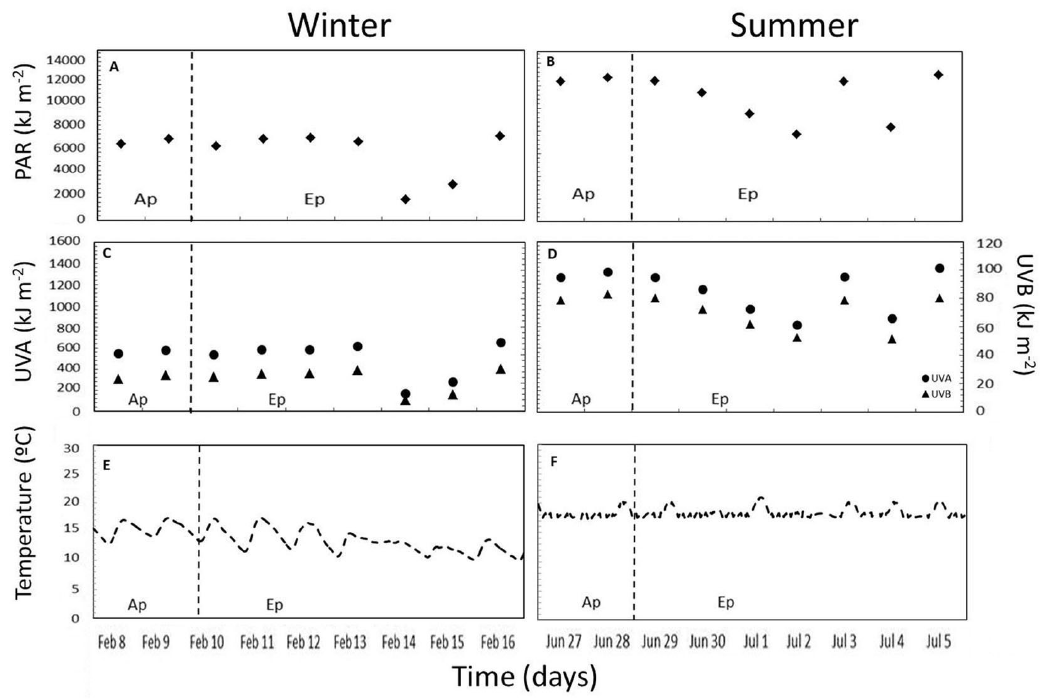
Fig. 1. – Daily integrated irradiance (DIE) in the air expressed as kJ m –2 of PAR (400-700 m) (A, B), UVA (320-400 nm) and UVB (280-320 nm) (C, D) in winter (February) (A, C) and summer (July) (B, D) (days). The harvesting of C. tamariscifolia was conducted at time 0, then the algae were incubated in 1.5-L cylindrical vessels for 2 days under decreased solar irradiance conditions (acclimation period, AP). After this period, the algae were incubated for 7 d under full solar irradiance (experimental period, EP). Average daily integrated irradiance was calculated from 8 to 16 February in winter and from 27 of June to 5 July in summer. Underwater temperature in the experiment in winter (E) and summer